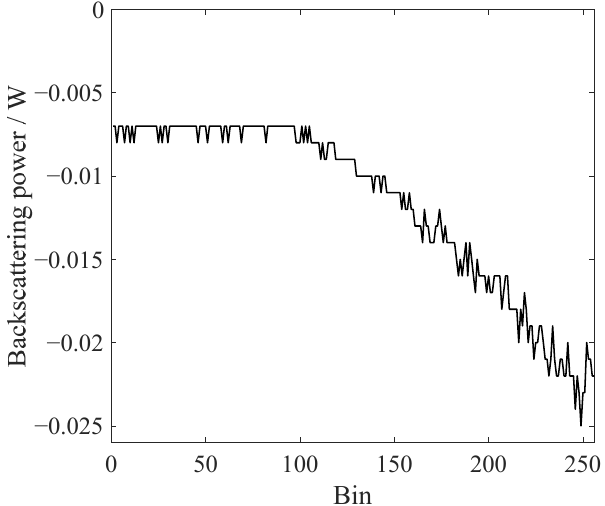
Figure 4. A waveform including negative echo powers (1 October 2019).